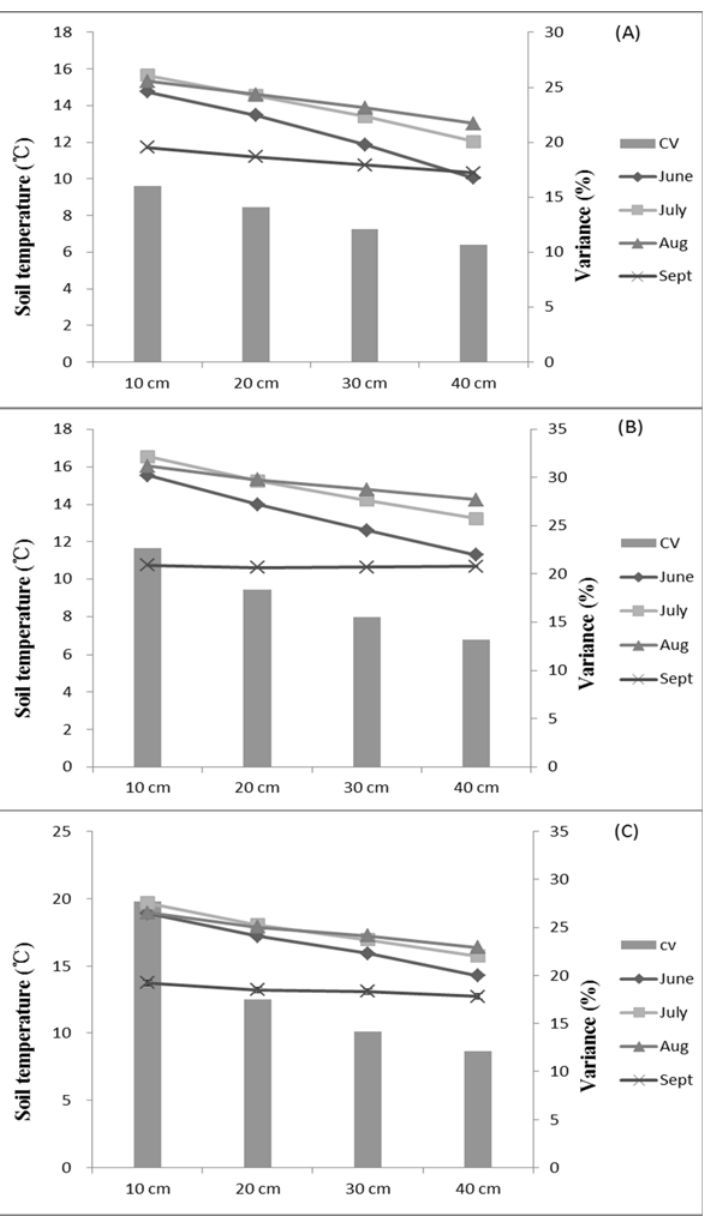
Fig 5. Soil temperatures for the three vegetation types during the rainy season. The variances (CVs, %) are also shown. (A) Soil-moisture content of artificial Larix spp., (B) soil-moisture content of Quercus mongolica , and (C) soil-moisture content of unused